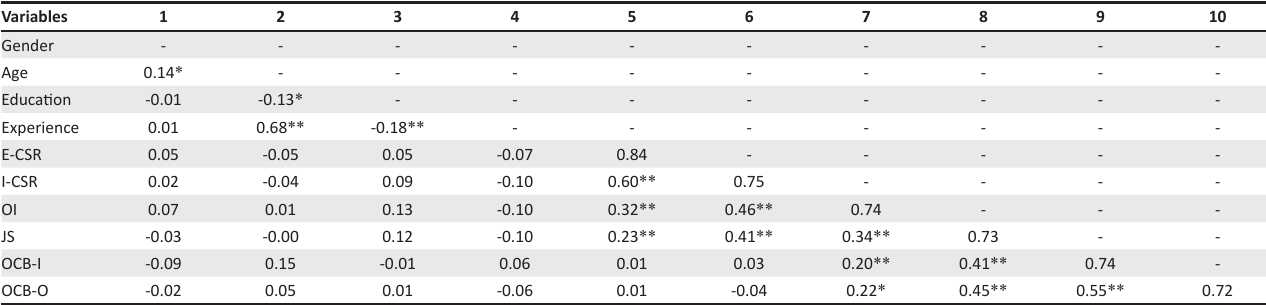
TABLE 2: Factor correlation matrix.